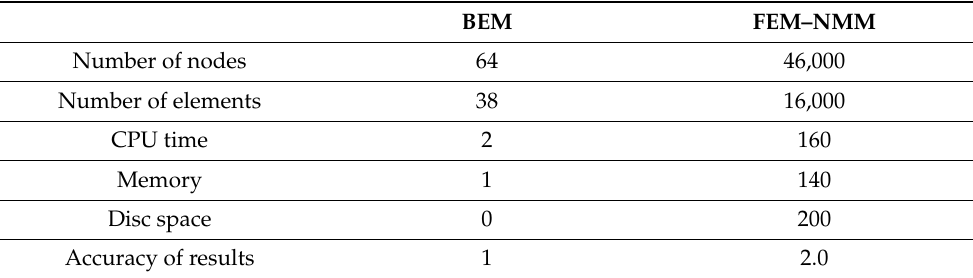
Table 2. A comparison of the required computer resources for modeling of ultrasonic wave propagation fractional order boundary value problems of functionally graded anisotropic fiber- reinforced plates.